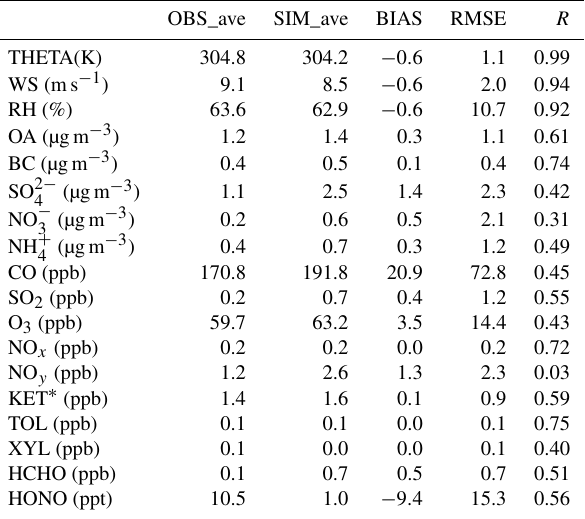
Table 3. Observed (OBS_ave) and simulated (SIM_ave) mean val- ues at an elevation between 2 and 4km for bias (BIAS), root mean square error (RMSE), and correlation coefficients ( R ) during EMeRGe HALO flights on 17 and 19 March 2018. KET ∗ : the ob- served acetone is applied to compare with simulated ketones